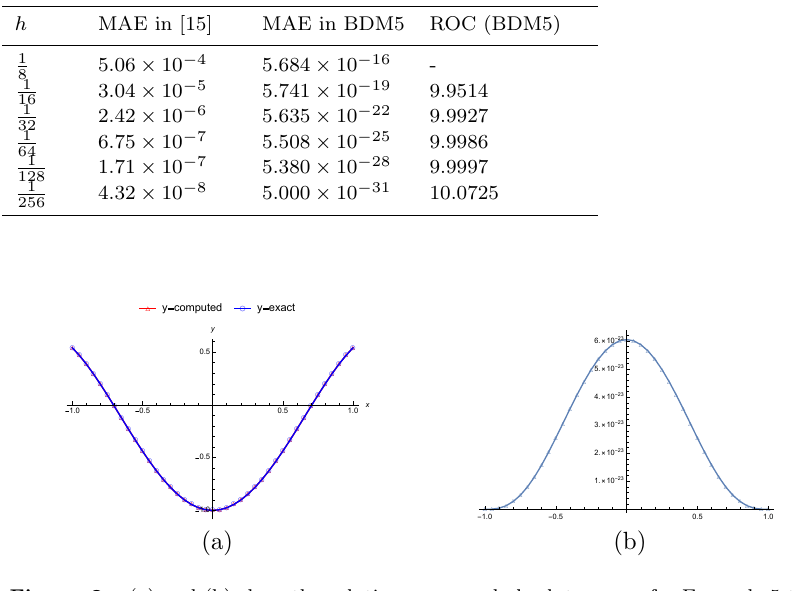
Figure 2. (a) and (b) show the solution curve and absolute errors for Example 5 taking